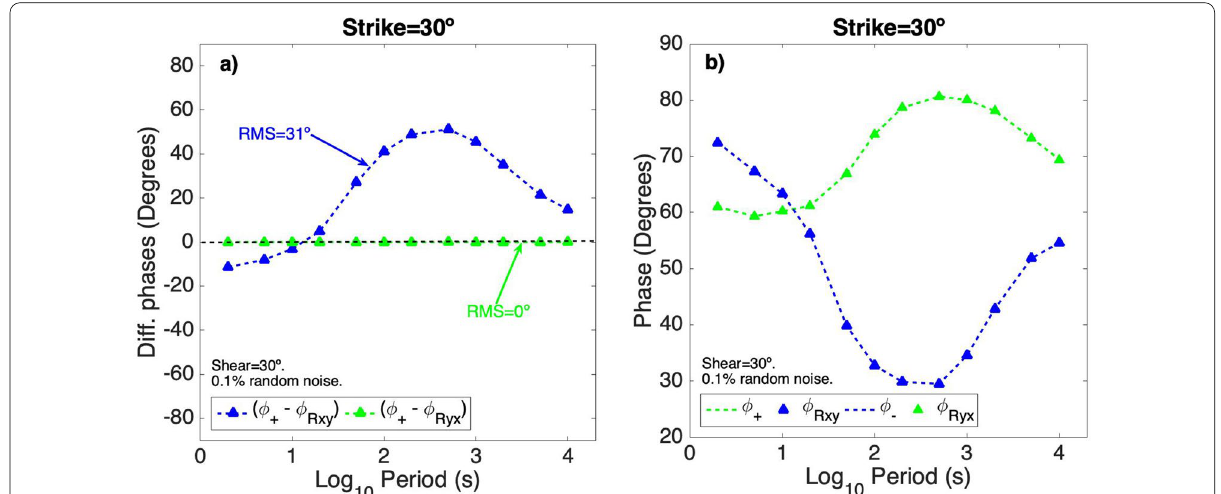
Fig. 7 a Differences of the phases of Z Rxy and Z Ryx and ∅ the phase of Z Ryx